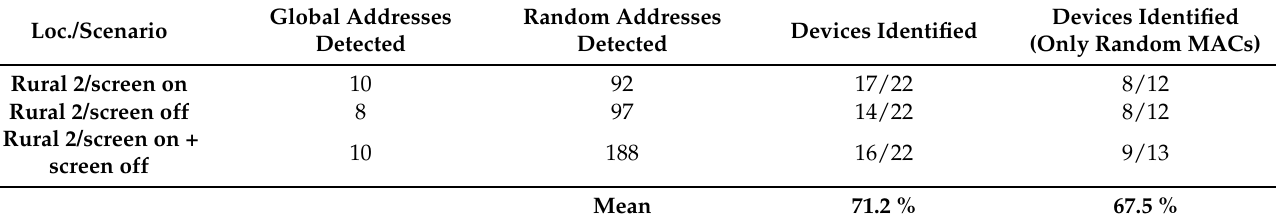
Table 6. MAC de-randomization results for all devices in a single group for the rural